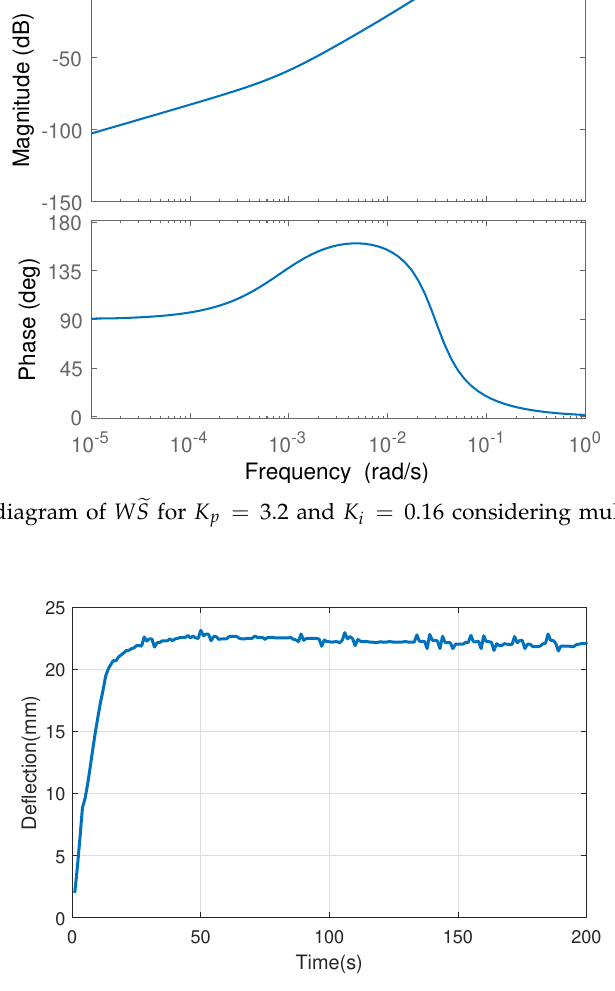
Figure 12. Deflection of the controlled system with multiplicative feedback uncertainty for 22mm reference using a robust PI